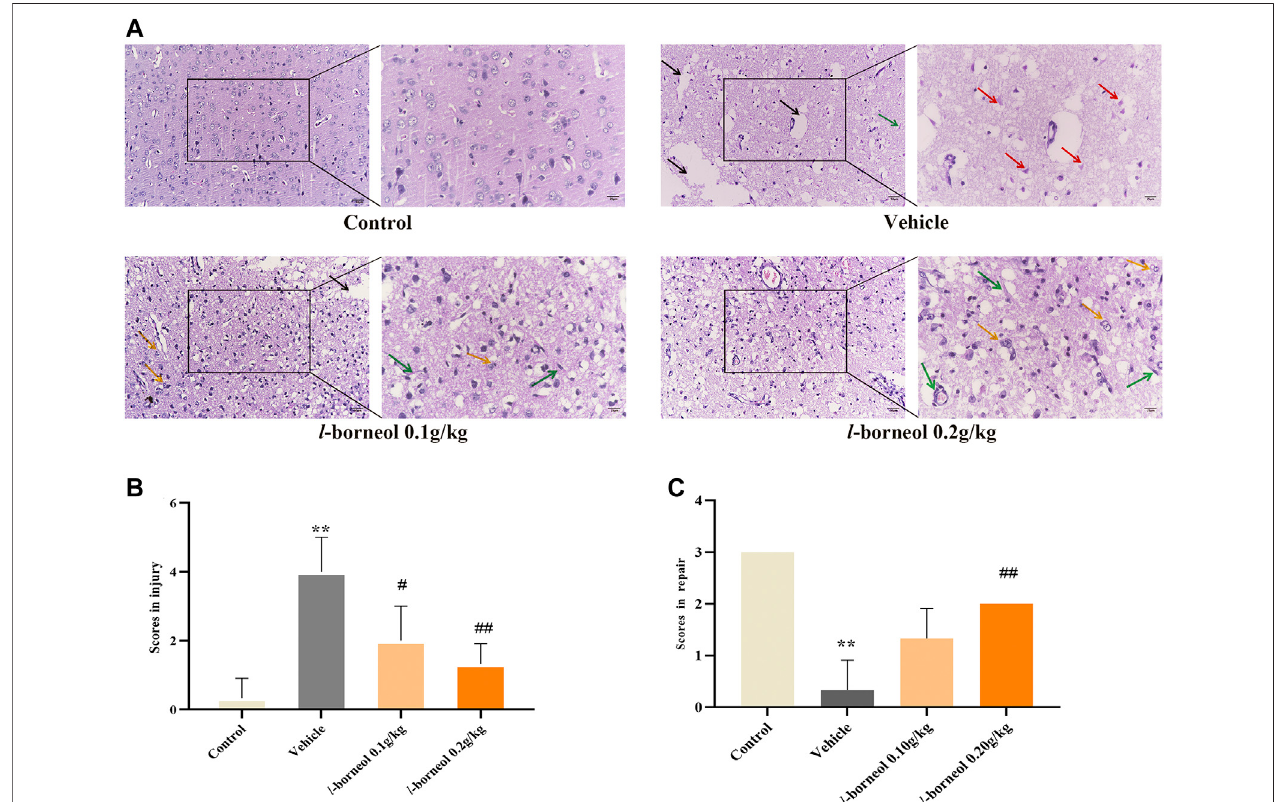
FIGURE 6 | Illustration of pathological changes using HE staining ( n (cid:2) 3). (A) HE results of each group, (B) Semi-quantitative analysis of pathological injury, (C) Semi-quantitative analysis of pathological repair. Red arrow represents red neuron, black arrow represents lique fi ed and necrotic nerve tissue, yellow arrow represents microgliaclearsoutnecroticneurons,greenarrowsrepresentsnewbloodvessels, ** p < 0.01,comparedwiththecontrolgroup; # p < 0.05, ## p < 0.01,comparedwiththe vehicle